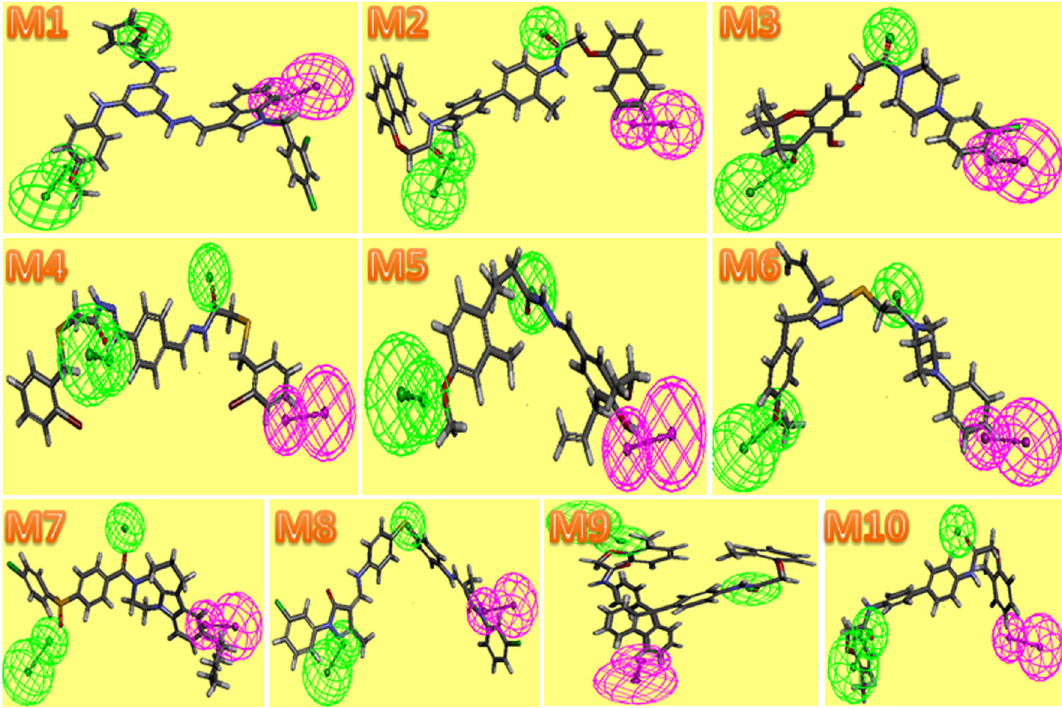
Fig. 5 3D structure of Hypo 4 binding with hits carried out by DS. Two colors represented two pharmacophore features, green represented HBA, magenta represented